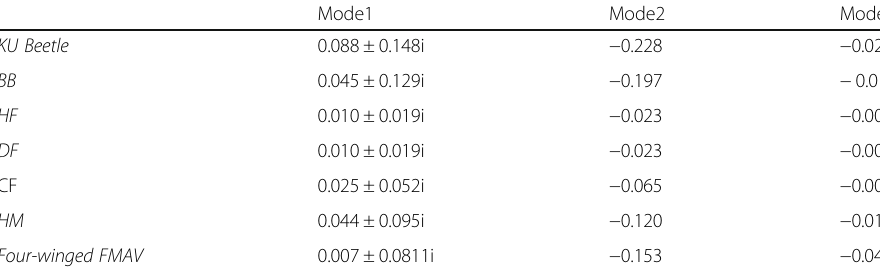
Table 10 Longitudinal modal comparison of FMAVs and insects Mode1